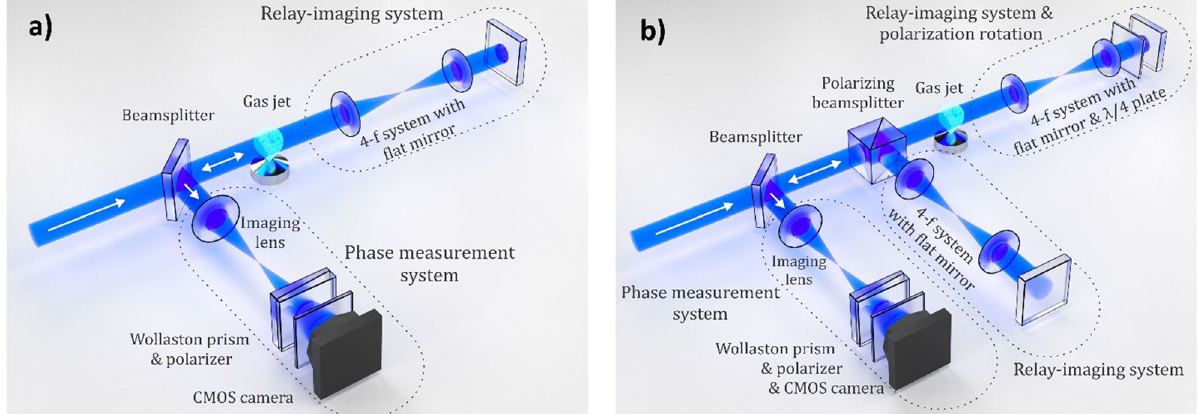
Figure 1. Schematics of the double-pass setup ( a ) and four-pass setup ( b ) for interferometric gas jet characterization. The first reflections of the beam on the beam splitters and their beam blocks are not